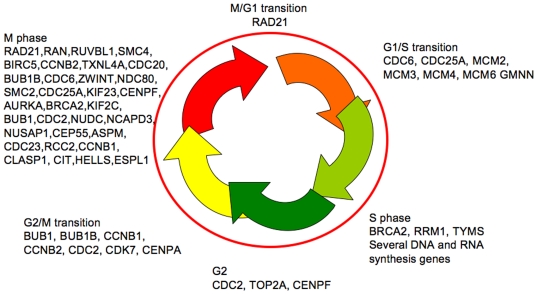
Schematic presentation of some of the overexpressed genes related to their activity in the various phases of the cell cycle (P<0.05).The M-phase genes are overrepresented.